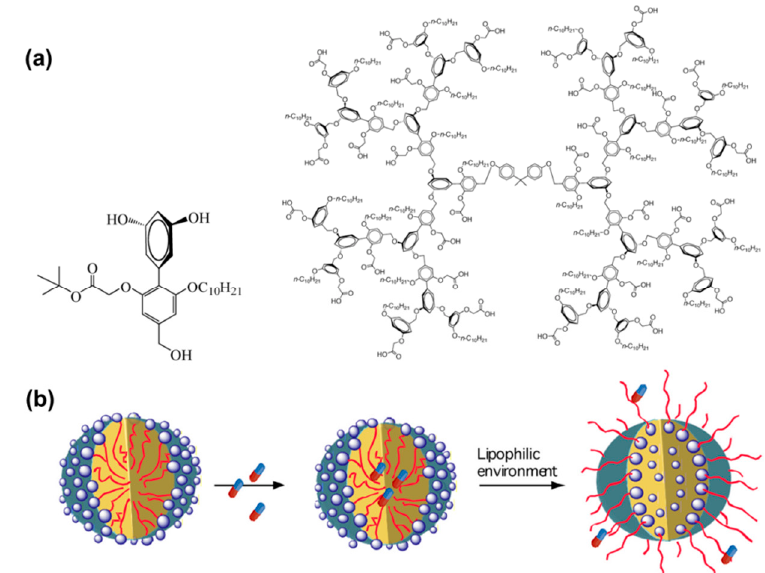
Figure 36. ( a ) The amphiphilic AB 2 monomer (i.e., on the left) was used to construct the final biaryl amphiphilic dendrimer structure (i.e., on the right). ( b ) Environment-dependent conformational micellar changes in biaryl-based amphiphilic dendrimers leading to potential new targeted drug release systems. Reprinted with permission from [103]. Copyright 2005 American Chemical Society.